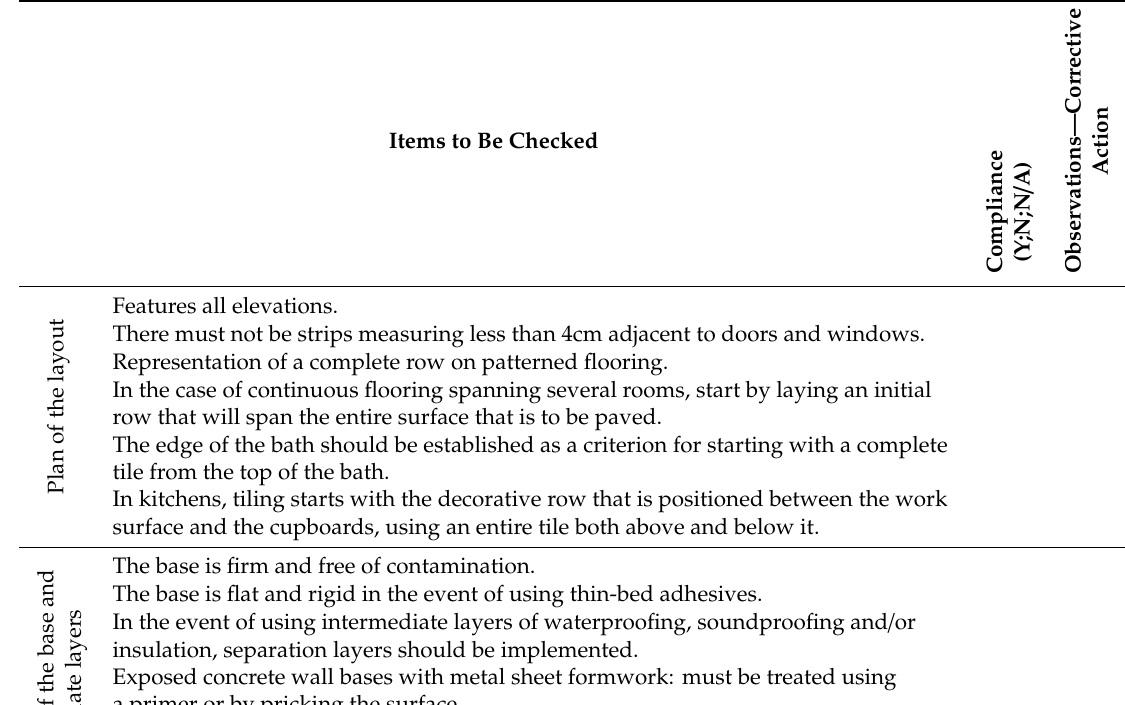
Table 4. Monitoring sheet for the ceramic tiling